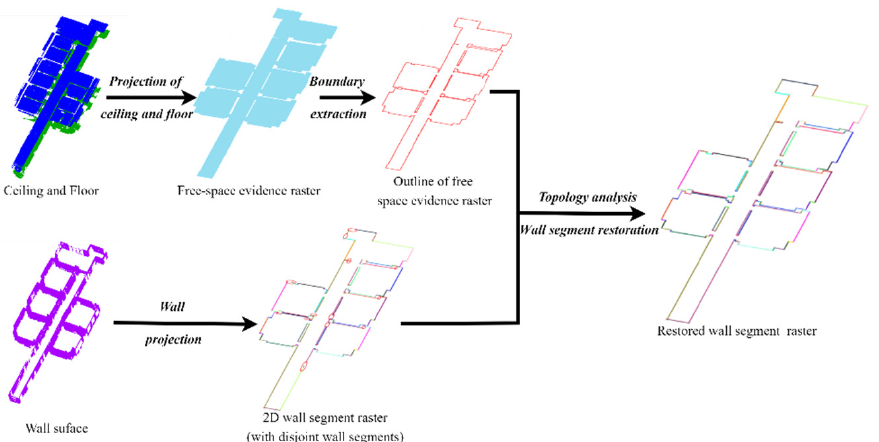
Figure 5. Wall surface extraction and restoration